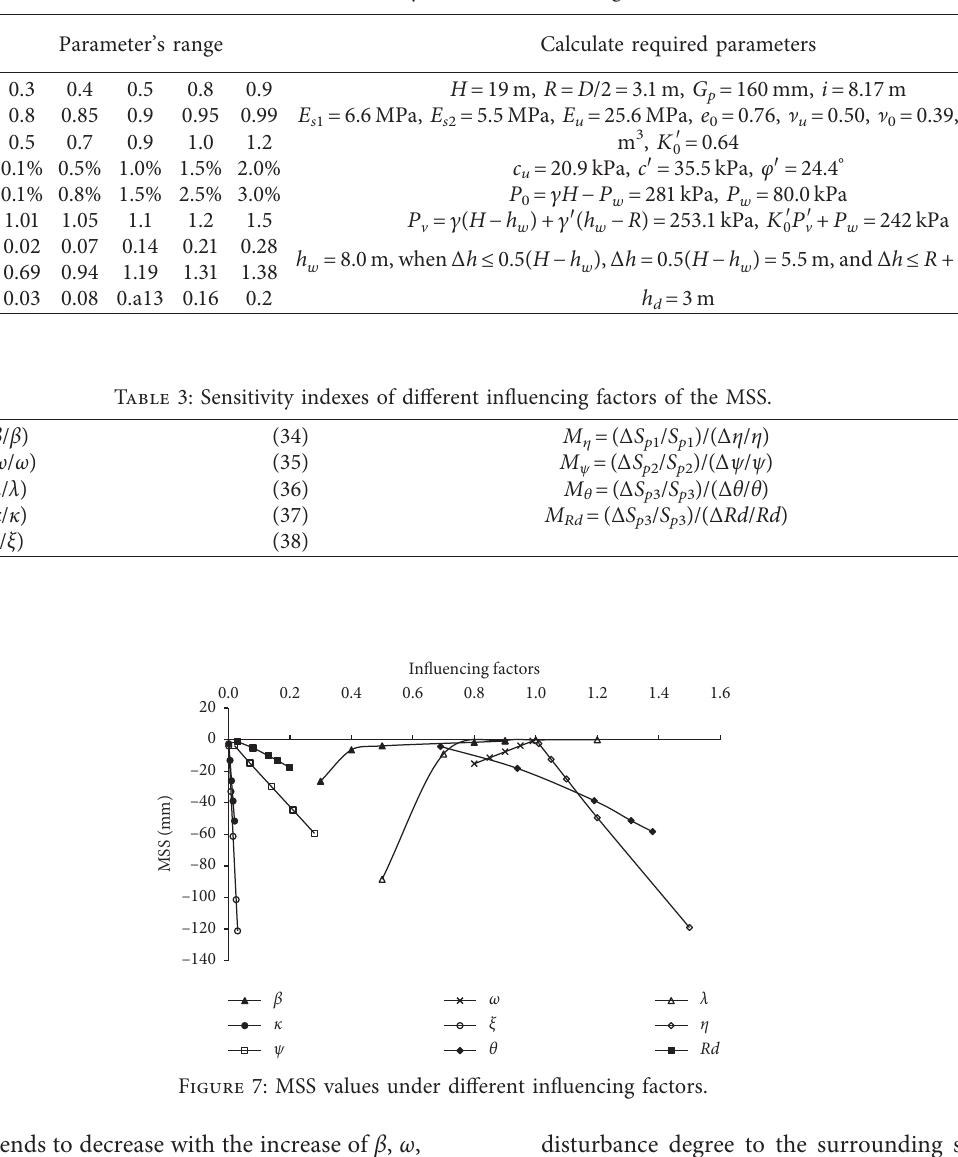
Table 2: Numerical analysis schemes for a single factor.